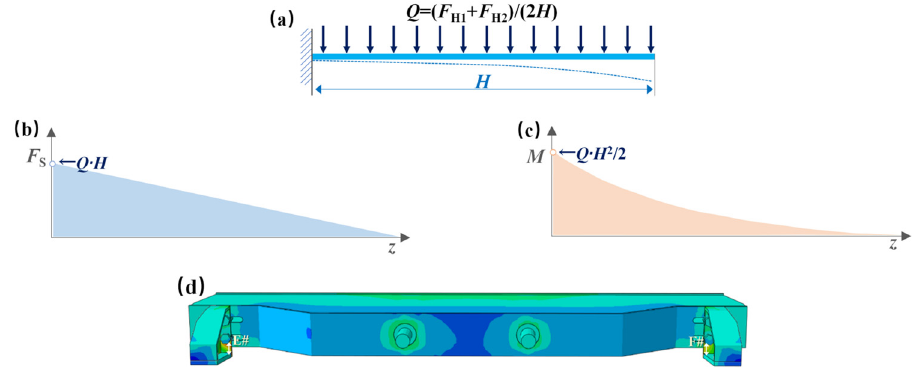
Figure 6: Cantilever beam analysis in horizontal loading: ( a ) mechanical structure; ( b ) shear force; ( c ) bending moment and ( d ) lateral strain.